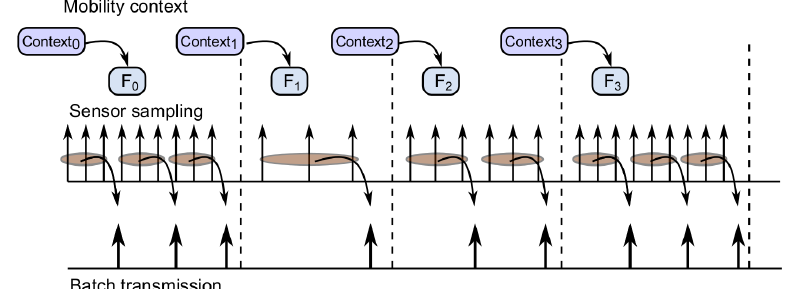
Figure 2. Conceptual view of the dynamic adaptation of sensing parameters and batch